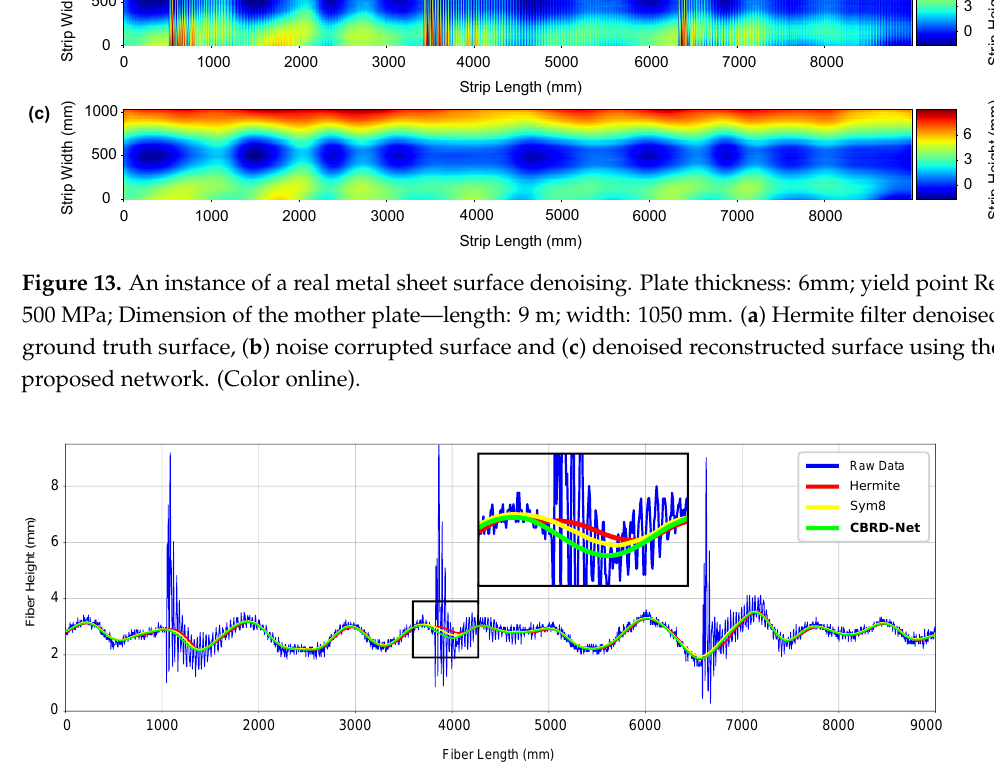
Figure 14. An instance of longitudinal fiber reconstruction, the blue line represents the raw 1D data from a fiber extracted from Figure 13, the red line shows the Hermite interpolation result, the yellow line shows Symlet results, and finally the green line depicts the CBRDNet denoised result. The inset provides a better detail of the results achieved by both Hermite and CBRDNet in the highlighted